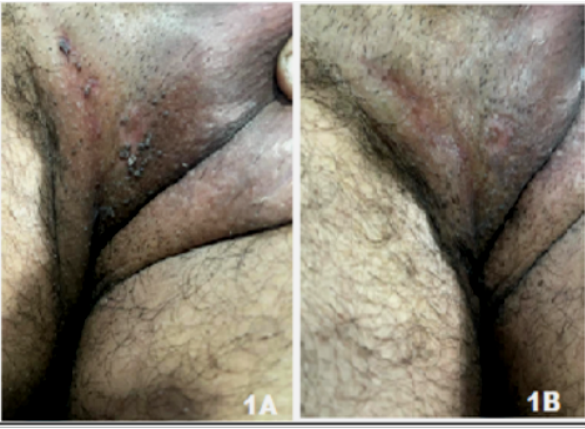
Fig. 1. A case of 32 years old male patient presented with geni- tal warts on the perineal areas before and after PPD injection. (A) a case of 32 years old male patient presented with multiple warts recurrent after electrosurgery from 3 months duration, lo- cated on the perineal area and upper thigh. Serum IL-17 level was 91.5 Pg/mL before PPD injection. (B) the same patient injected 10 tuberculin units’ intralesionally every session for six sessions with 2 weeks interval. Complete removal was obtained without scar- The mean serum level of IL-17 in patients with geni- ring. Serum IL-17 level was 132.6 Pg/mL after PPD injection. tal warts was significantly lower ( P < 0.05) than the con- trol group, 81.1 ± 64.2 pg/mL versus 118.9 ± 93.8 pg/mL The mean serum level of IL-17 after PPD injection respectively. Mean serum level of IL-17 after PPD intrale- was significantly higher ( P < 0.05) in responders to PPD sional injection was significantly higher ( P < 0.05) than be- injection than non-responders, 118.54 ± 69.0 versus fore PPD intralesional injection, 107.1 ± 66.8 pg/mL versus